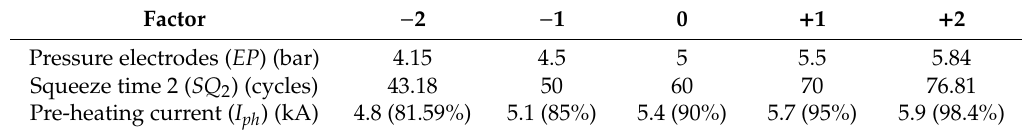
Table 6. Factors’ levels for the CCD.